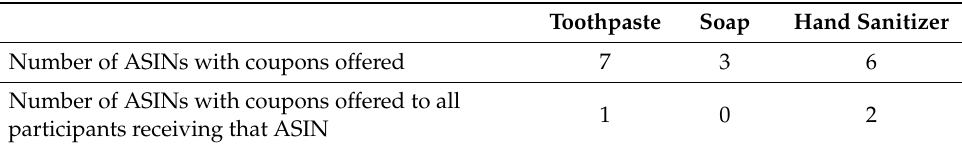
Toothpaste Soap